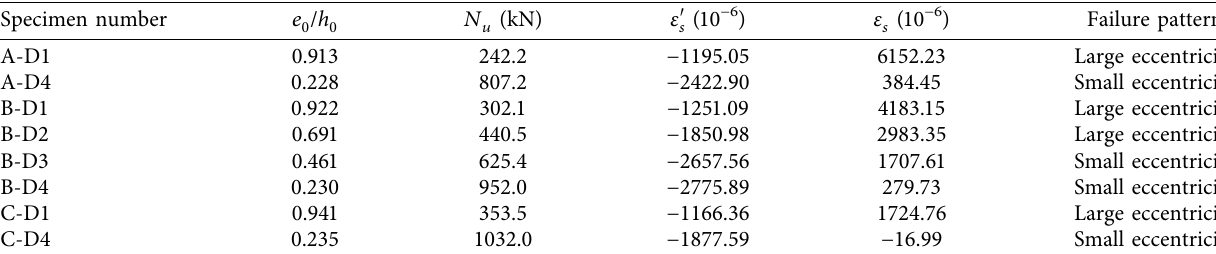
Figure 10: Comparison of the influence of eccentricity on the load-deflection curve. Table 4: Main test